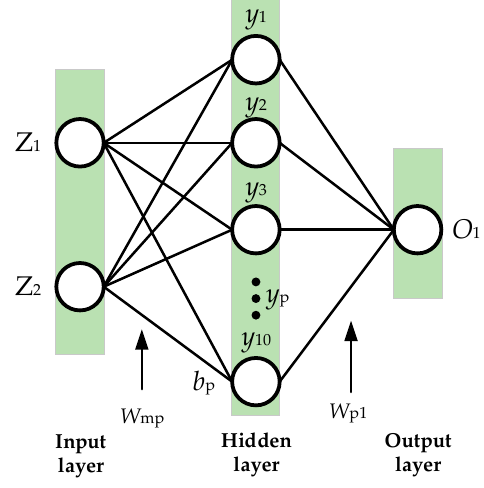
Figure 6. The structure of BP neural network.